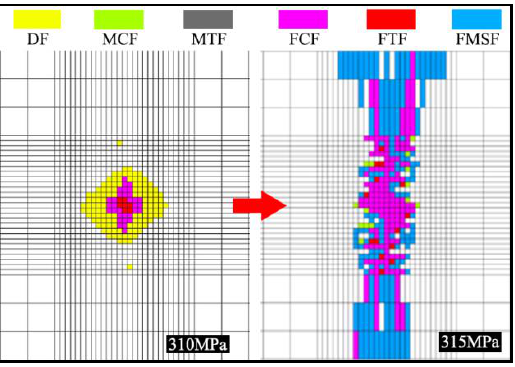
Figure 9. Progressive damage process of the laminate after the impact of 16.8 J.